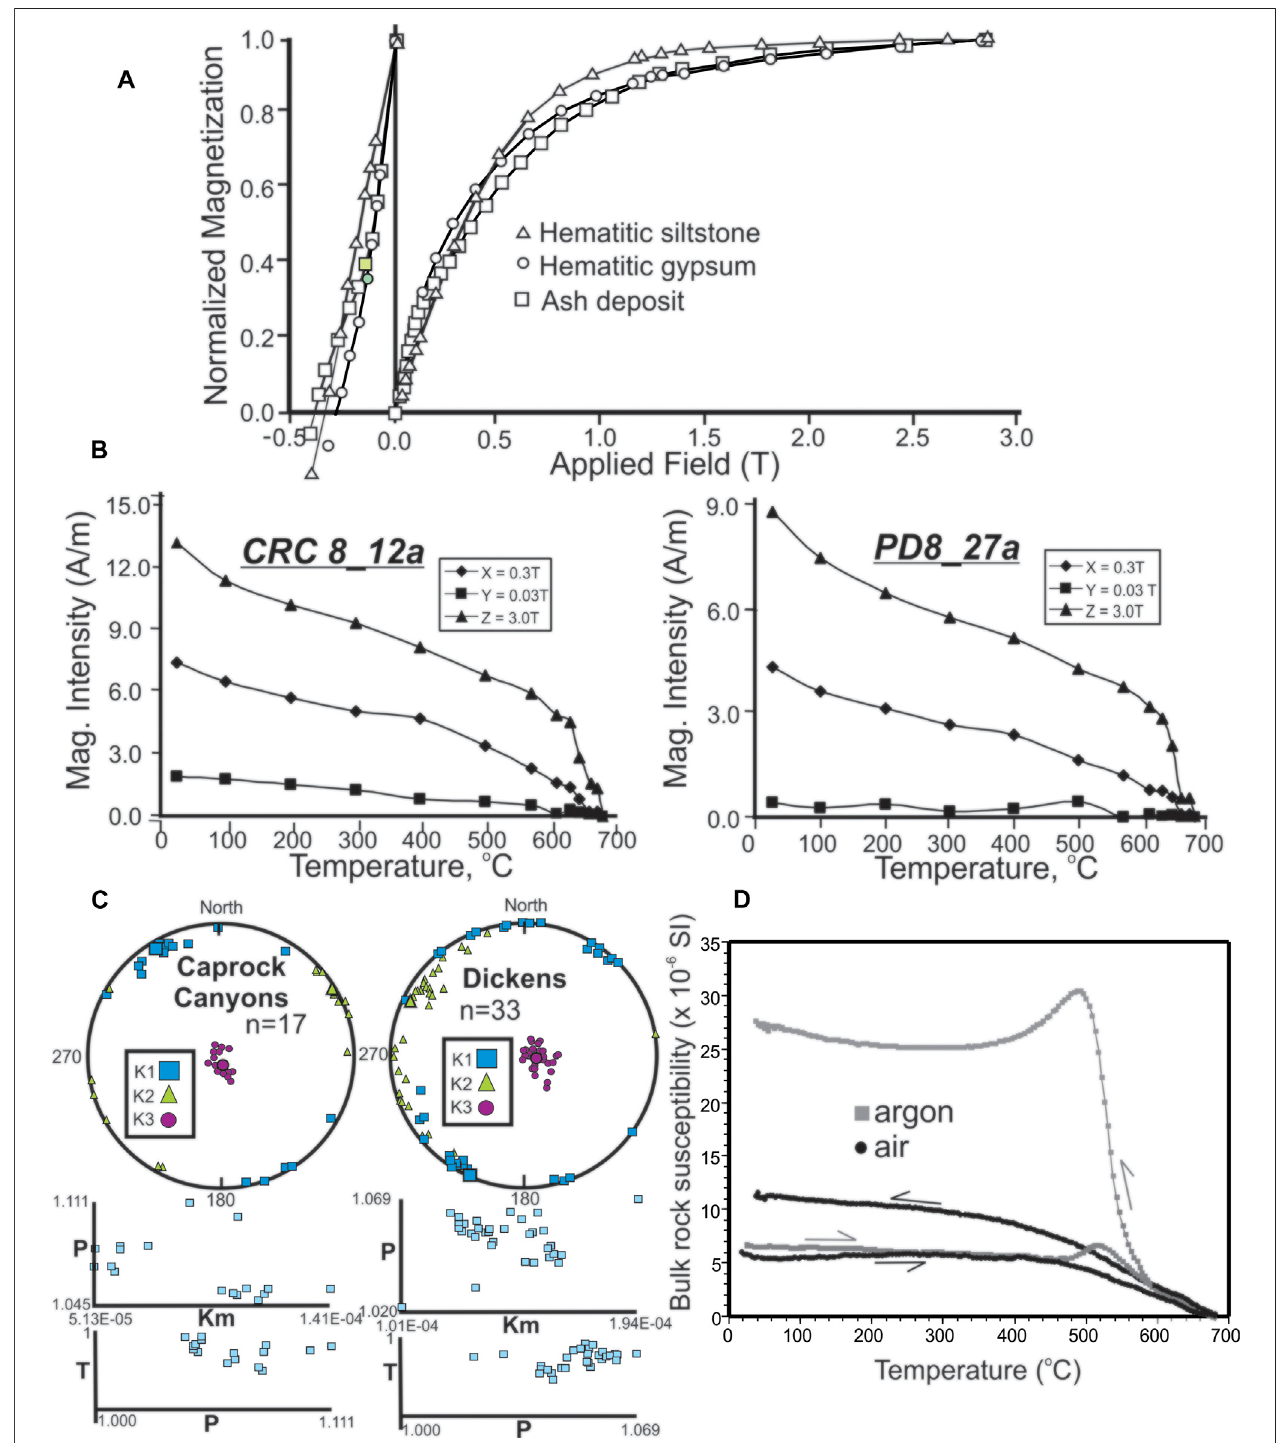
FIGURE 9 | (A) Plots showing the acquisition of isothermal remanent magnetization (IRM) and back fi eld direct- fi eld demagnetization for specimens from selected samplesfromtheDickenslocality.Inback fi elddemagnetization,thecross-overpointprovidesthecoercivityofremanence. Thefactthatsaturationornear-saturationby close to3.0 Tindicatesthat ahigh coercivitymagnetic phase(likely hematite) isthe principal magnetic phase present. Thisisconsistentwiththecoercivityofremanence values obtained. The concave-downward shapes to the curves, however, shows the additional presence of a considerably lower coercivity phase (most likely a combinationofmagnetiteandmaghemite).Additionaldetailsarein SupplementalInformation . (B) Plotsshowingtheresultsofprogressivethermaldemagnetizationof three-component thermal demagnetization of isothermal remanent magnetization (IRM) following the approach of Lowrie (1990). Specimens from samples collected at